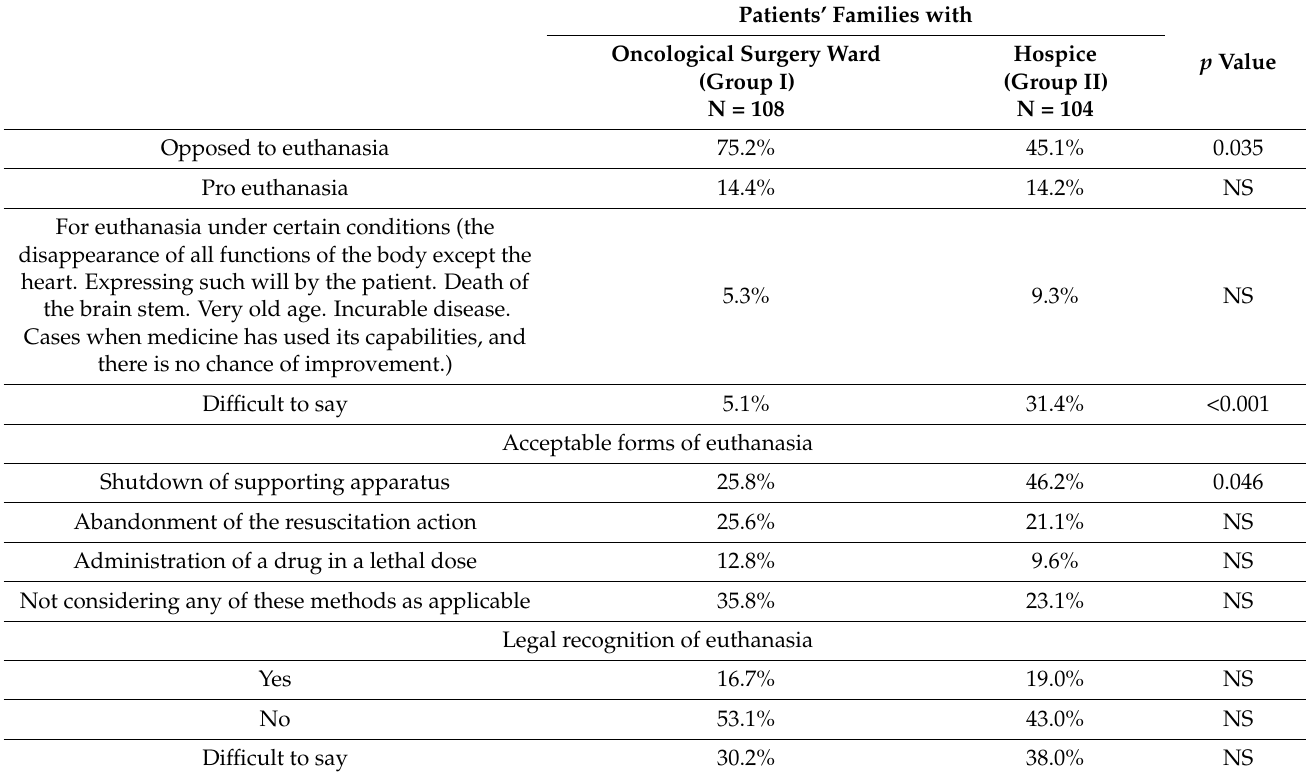
Patients’ Families